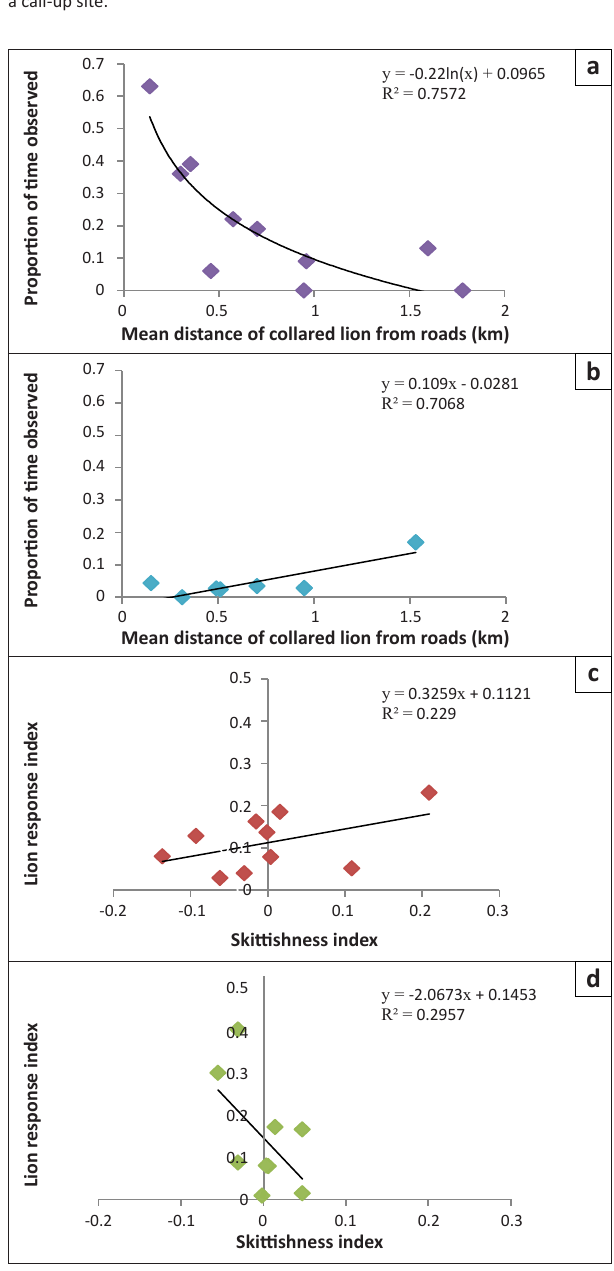
FIGURE 2: The effect of distance on amount of time that lions were observed during three days shortly after capture (a) and (b). The effect of lion skittishness on the chance that lions will respond to a call-up (c) and